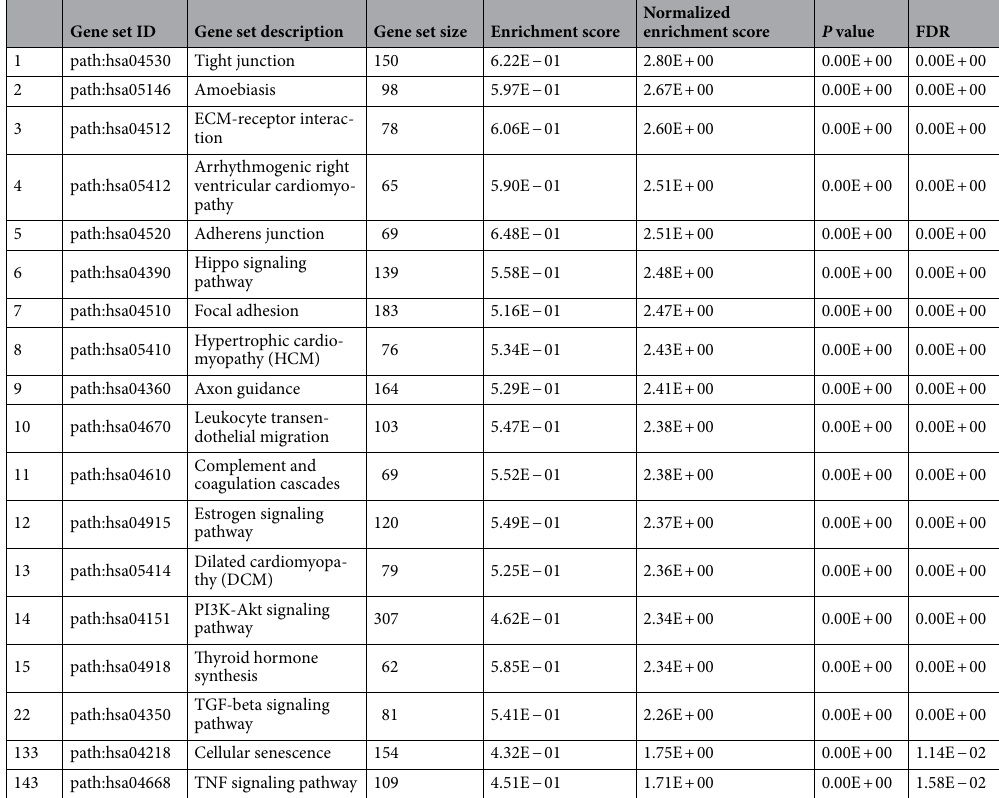
Table 2. KEGG pathway analysis of F3 + BALF cells derived from severe COVID-19 patients. Ranked in order of normalized enrichment score